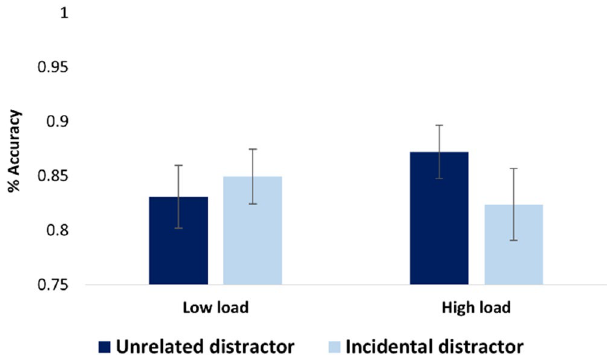
Figure 4. Results in Exp. 3. Load X recognition condition interaction: p < .009. Error bars indicate standard error of the